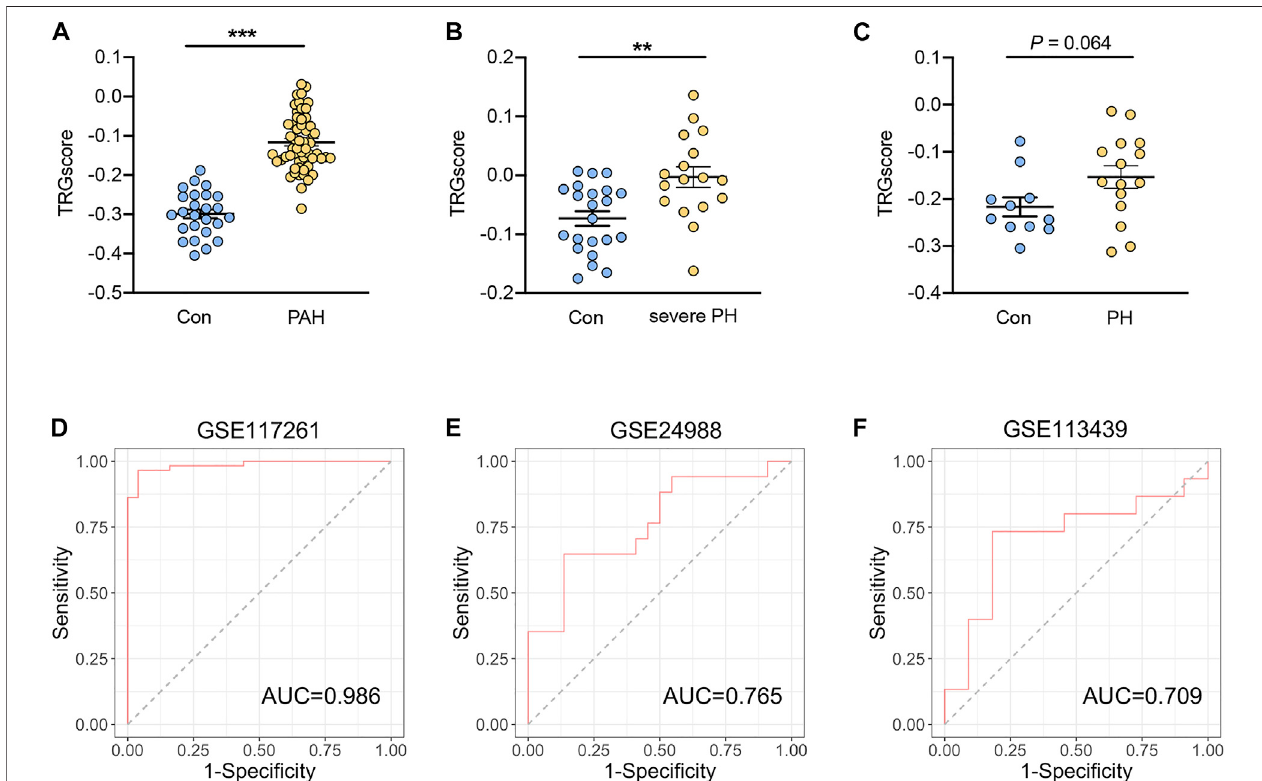
FIGURE5| DiagnosticperformanceofTRGscoreforthepatientswithPH. (A – C) TRGscorebetweenpatientswithPAH(group1 PH)fromtheGSE117261dataset (A) ,severePHfromtheGSE24988 dataset (B) ,andPHfromtheGSE113439dataset (C) werecompared withthecorrespondingcontrols,respectively. (D – F) Receiver operation characteristic curves of TRGscore to distinguish PH from controls in GSE117261 (D) , GSE24988 (E) , and GSE113439 datasets (F) , respectively. Data represent mean ± SEM. ** p < 0.01; *** p < 0.001 compared to control subjects, as analyzed by the unpaired t- test.